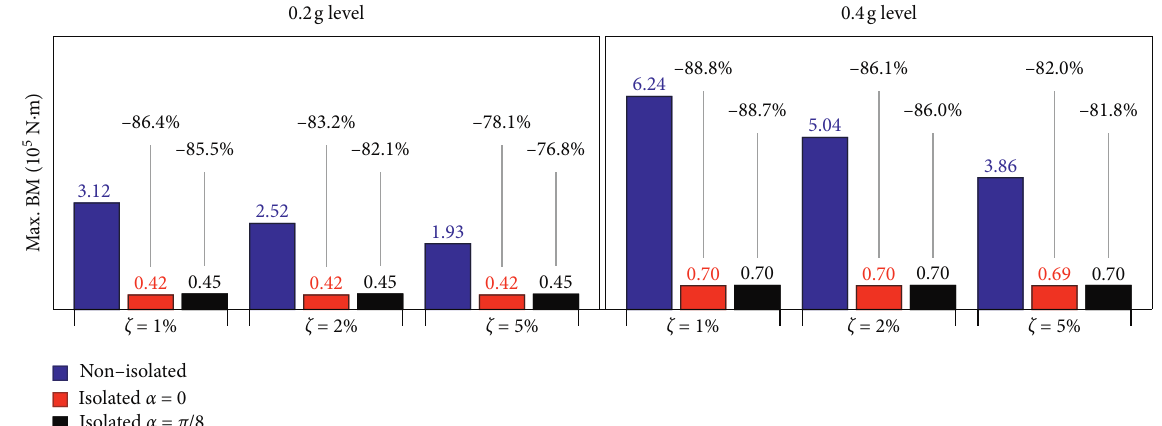
Figure 17: Maximum base moments (BM) of the nonisolated and isolated system and their change under different parameters of ζ and α at two seismic qualification levels.